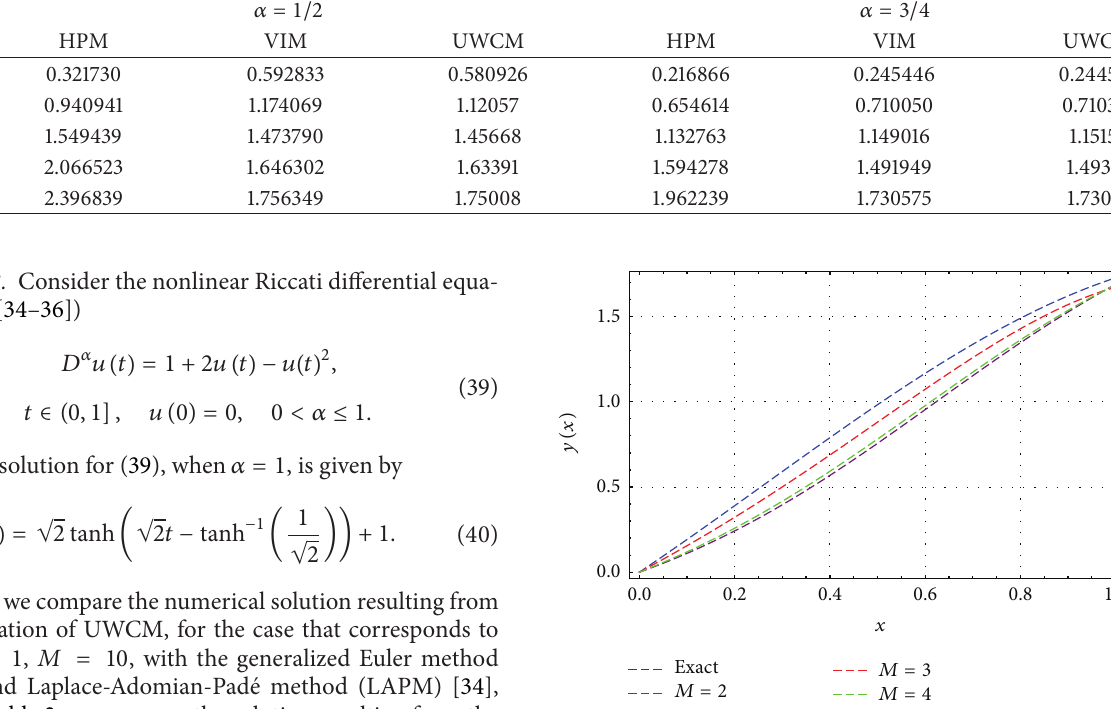
Figure 1: Different solutions of Example